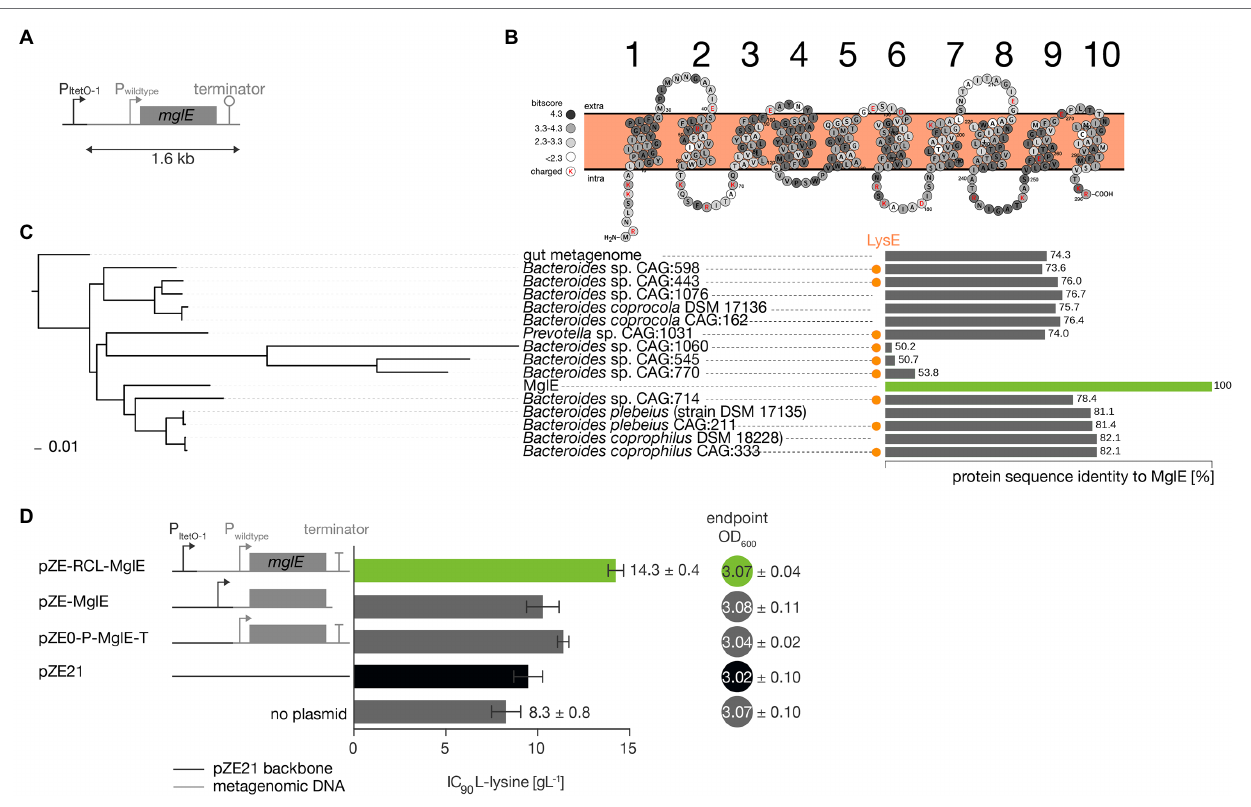
FIGURE 2 | In silico analysis of the metagenomic insert contained in pZE-RCL-MglE plasmid and L-lysine tolerance of its subclones. (A) The metagenomic insert present in the pZE-RCL-MglE plasmid is shown. P: promoter region, MglE: membrane bound transporter protein, and T: terminator sequence. (B) The membrane topology of the MglE transporter protein showing 6 cytoplasmic regions, 5 periplasmic regions, and 10 transmembrane α -helices. The 15 BLASTp hits with a > 50% sequence identity were aligned to MglE and the conservation (bitscore) for each residues was calculated using the Biopython package (Cock et al., 2009). (C) A Maximum Likelihood phylogenetic protein tree containing all the significant (sequence identity >50%) BLASTp hits in the UniProtKB database against MglE. The percentage identity of the 15 hits is shown as horizontal bars. The presence of a LysE family member in the genomes is shown with an orange dot. The highest homology with MglE is found in Bacteroides coprophilus CAG:333, with 82% sequence identity. (D) The strategy for subcloning the MglE transporter with or without its native promoter and the resultant L-lysine tolerance phenotypes for the E. coli C4860 strain are shown. The biomass of the strains (at 24 h) cultured in LB media was also shown in terms of OD in closed